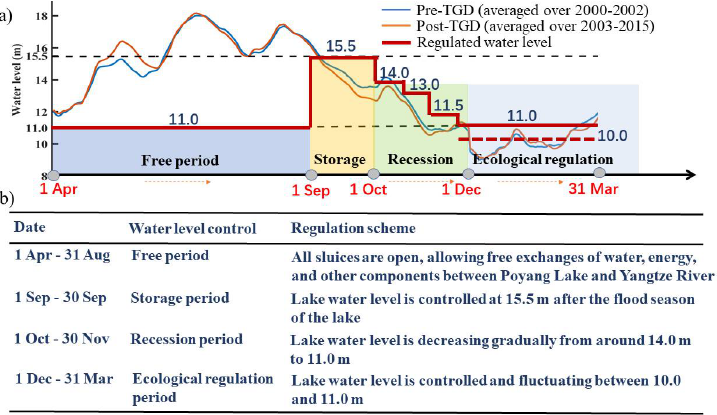
Figure 3. ( a ) Conceptual diagram showing the regulation scheme for the PLHP. ( b ) Corresponding lake water level changes of the PLHP under different periods, according to Lai et al.